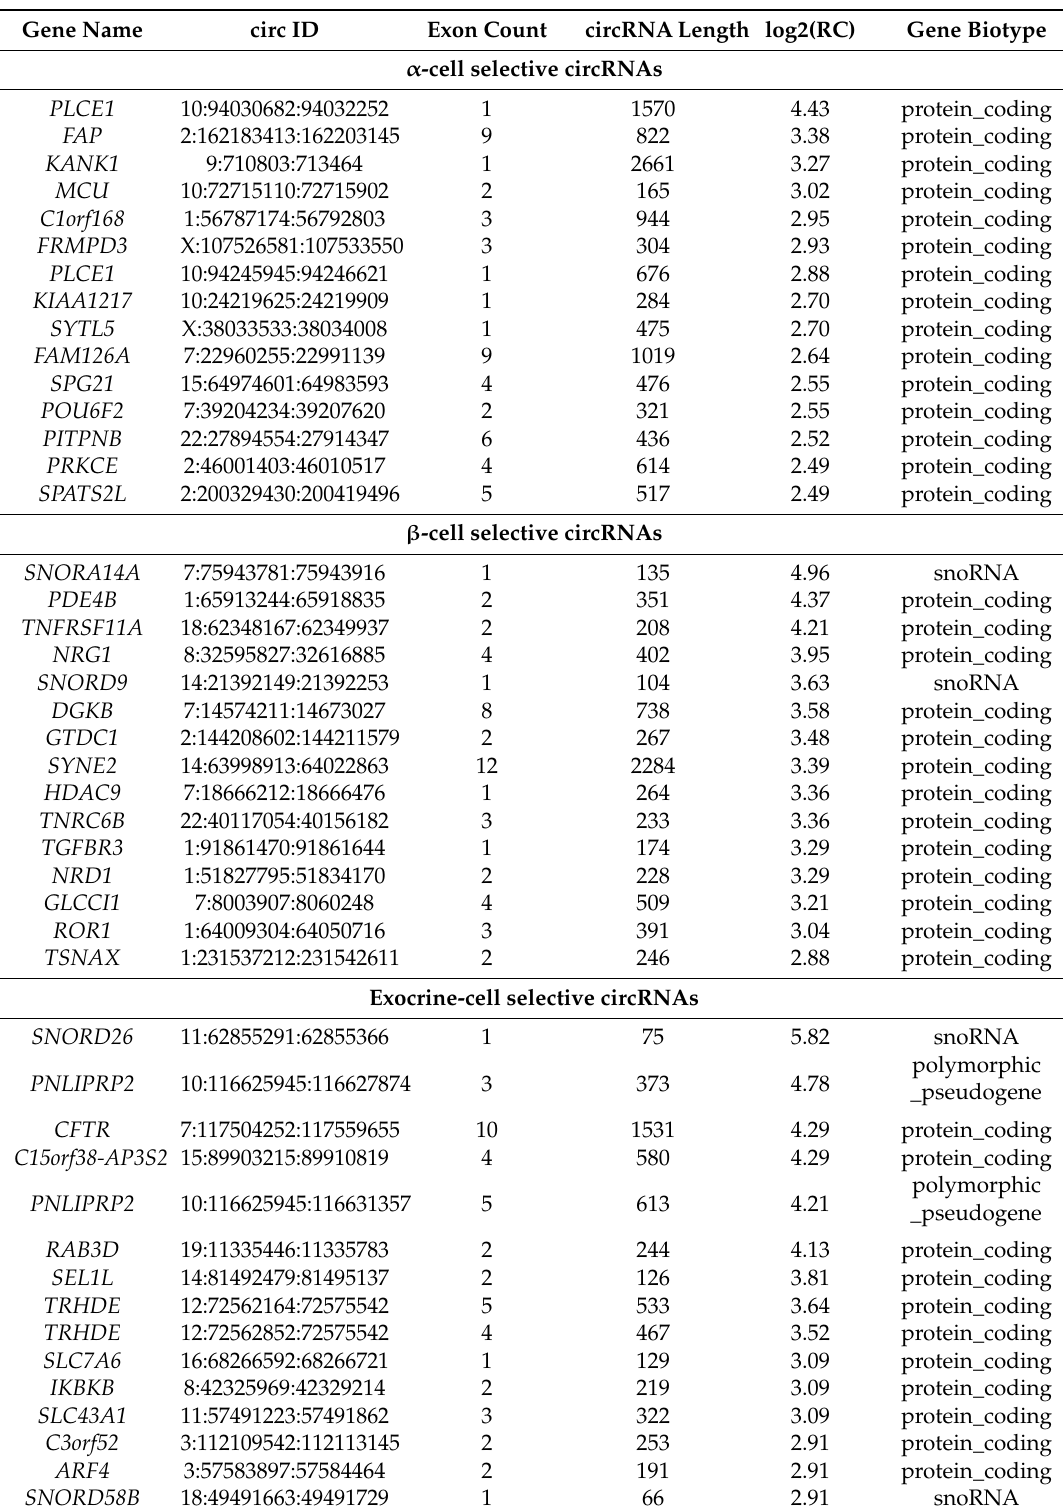
Table 5. Top highly and selectively expressed circRNAs for α -, β -, and exocrine cells. The averaged log-transformed junction read counts (log2(RC) are shown as a measure of normalized expression for each circRNA. Other columns include the total number of exons for each circRNA as represented by exon Count, circRNA length, and host gene name and